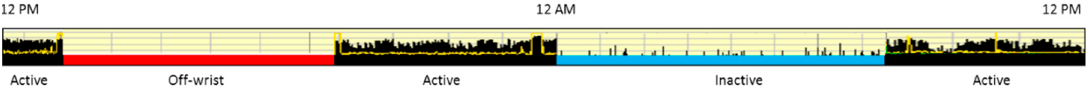
Figure 3. Example of off-wrist, active and inactive data. Movement data (arbitrary units) are plotted as vertical black lines over time (x-axis); light data are shown as a yellow line. Off-wrist periods (red horizontal bar) are characterized by the absence of activity bouts for prolonged periods of time (with or without light information). Active periods (black horizontal bar) are visible as high-density, high- or low-activity bouts (usually with elevated light levels). Inactive periods (blue horizontal bar) are represented by low-density, low-activity bouts (and usually an absence of light).